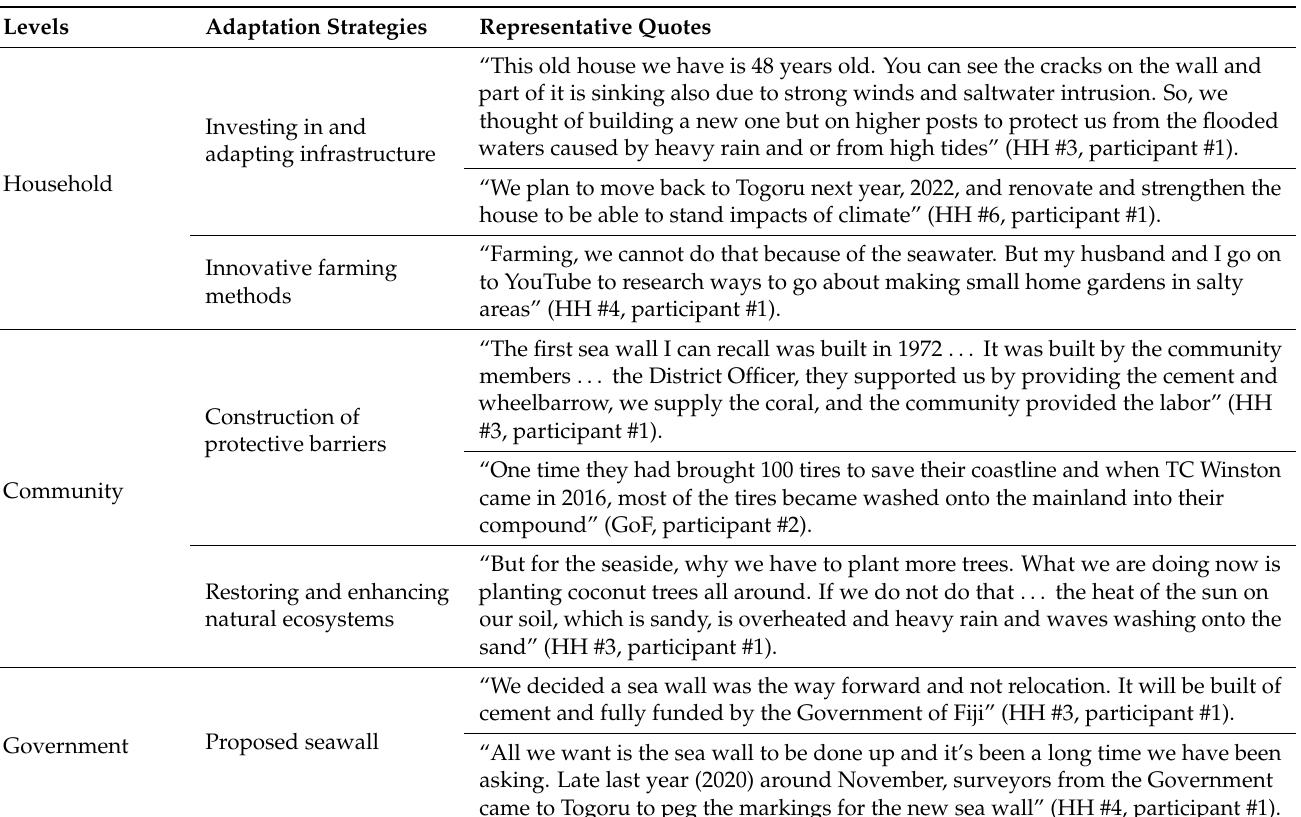
Table 2. Adaptation to coastal hazards at the household, community, and government